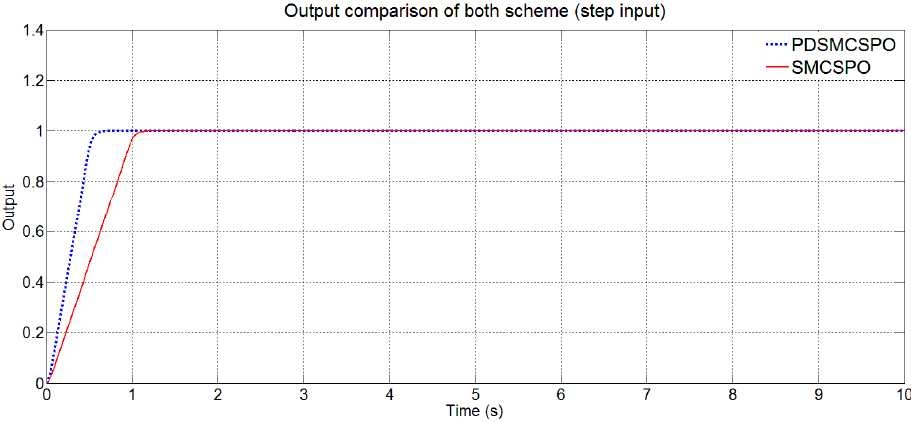
Figure 12. Output response of both schemes.